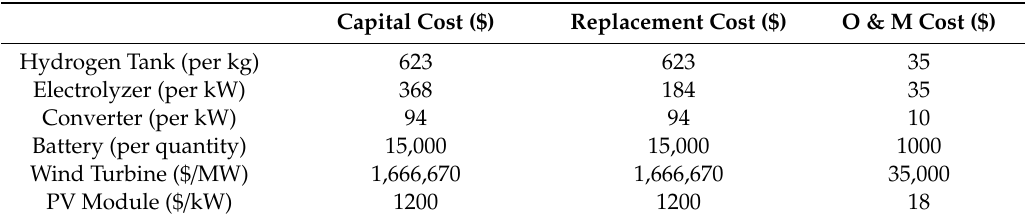
Table 2. Cost of the